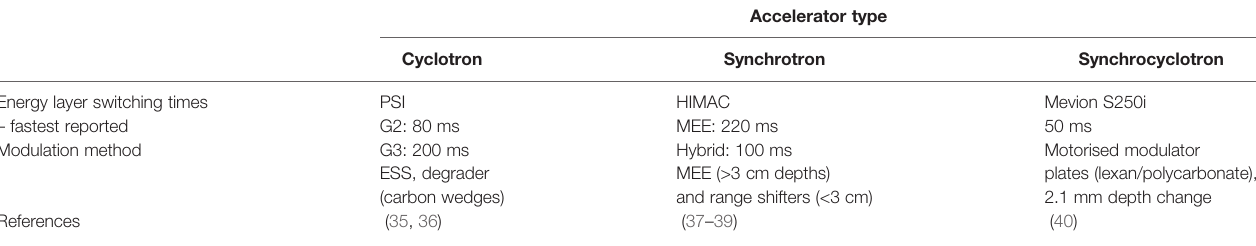
TABLE 1 | Reported minimum ELSTs ([T2]) for currently used clinical cyclotron, slow cycling synchrotron and synchrocyclotron